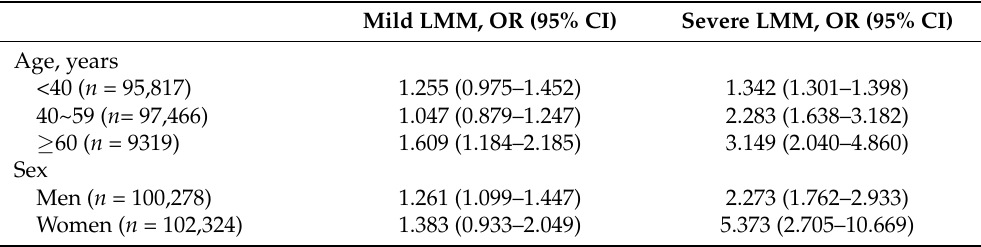
Table 4. Subgroup analyses by age and sex for associations of increased CEA with